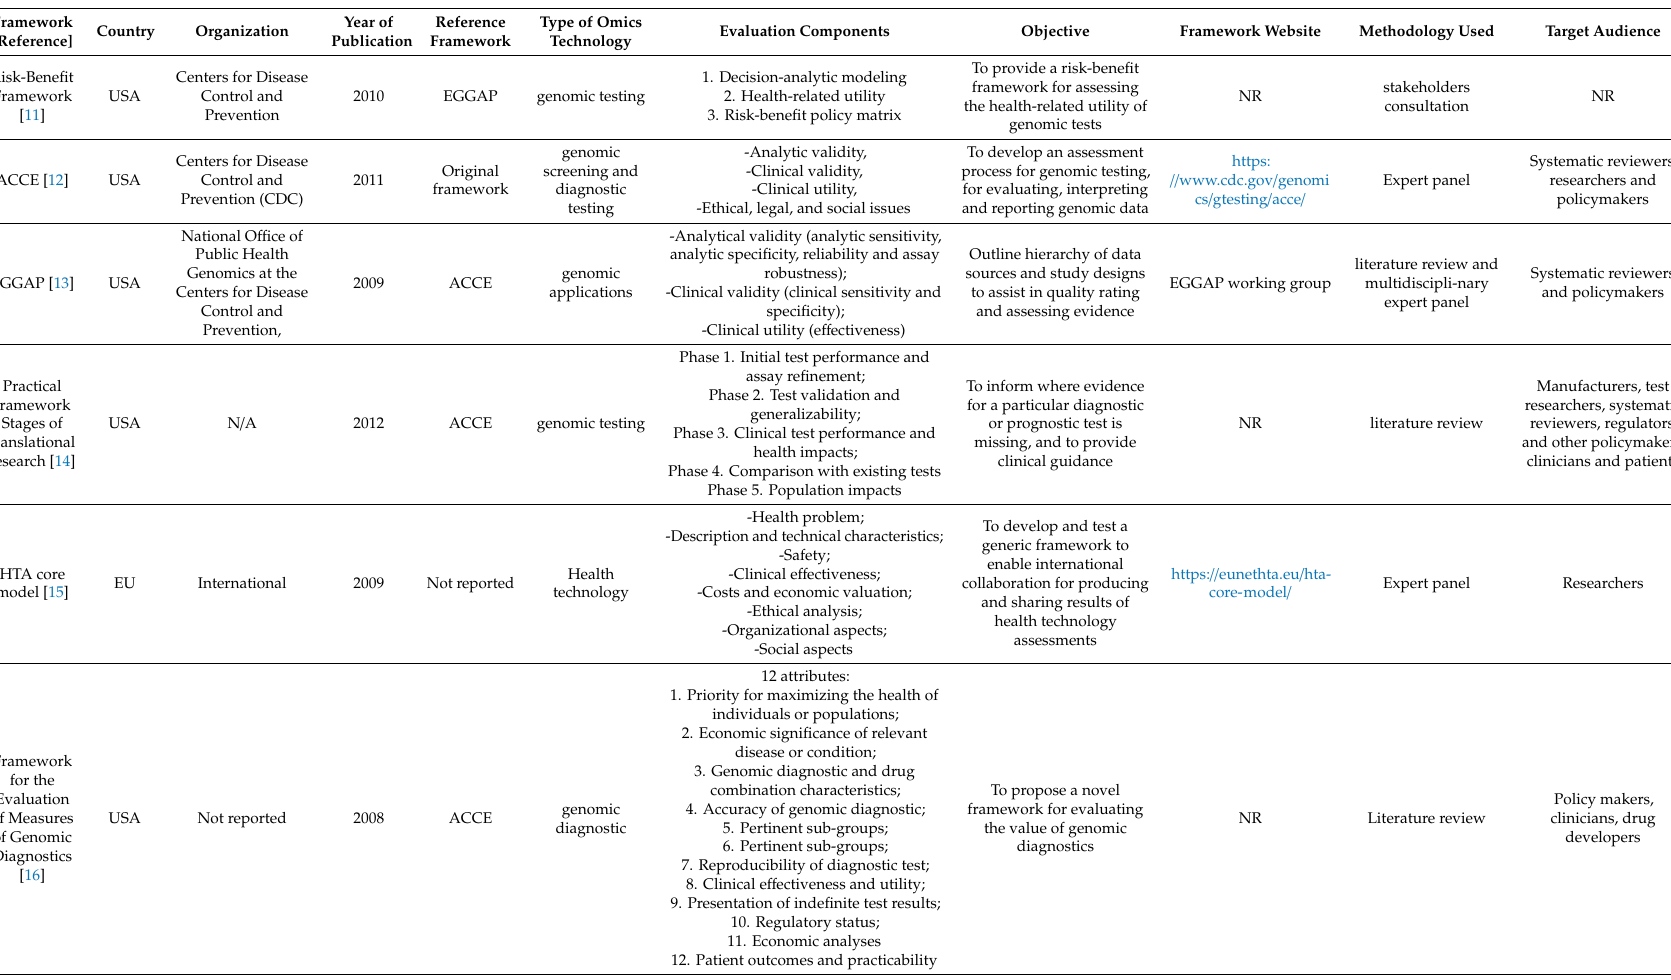
Table 1. Characteristics of the twenty-two value frameworks for the evaluation of omics technologies, retrieved from the twenty-three articles included in the systematic